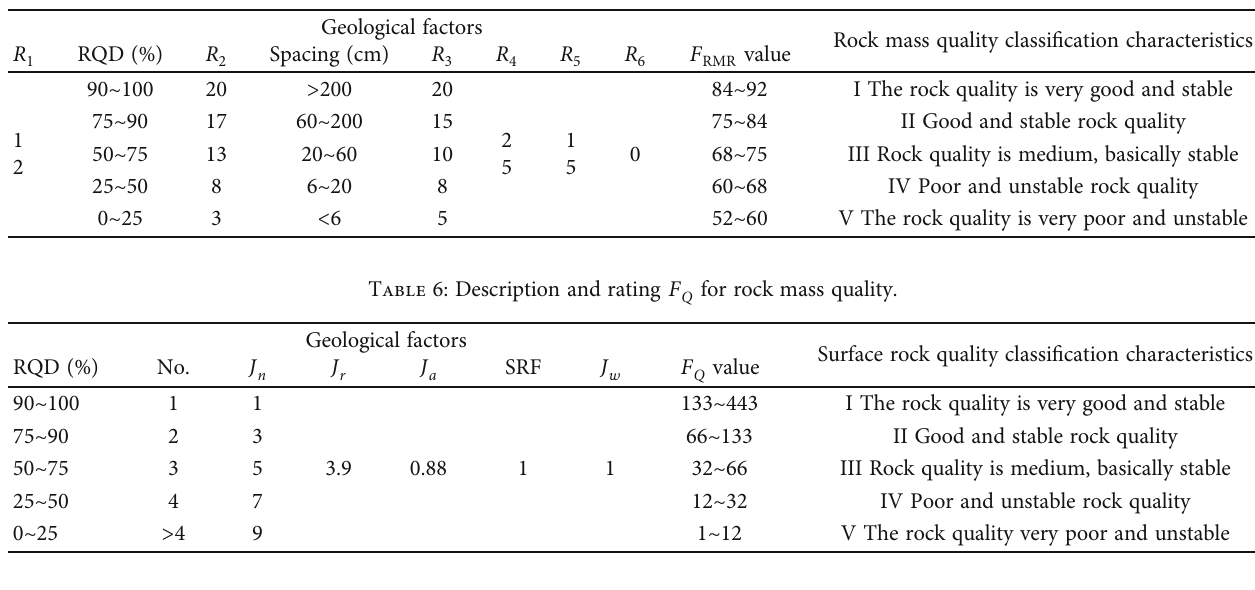
Table 5: Description and rating F